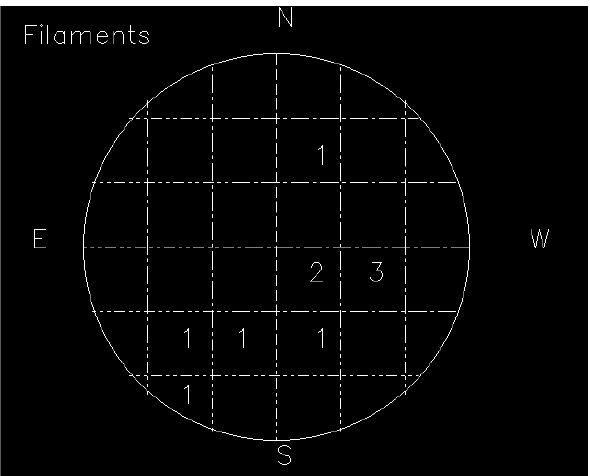
Fig. 10. Positions on the disk of the solar sources of the CMEs selected in Table 1 (column 7) in the case of association with fila- ments. Lines are drawn every 30 ◦ and numbers of cases in each box are indicated.